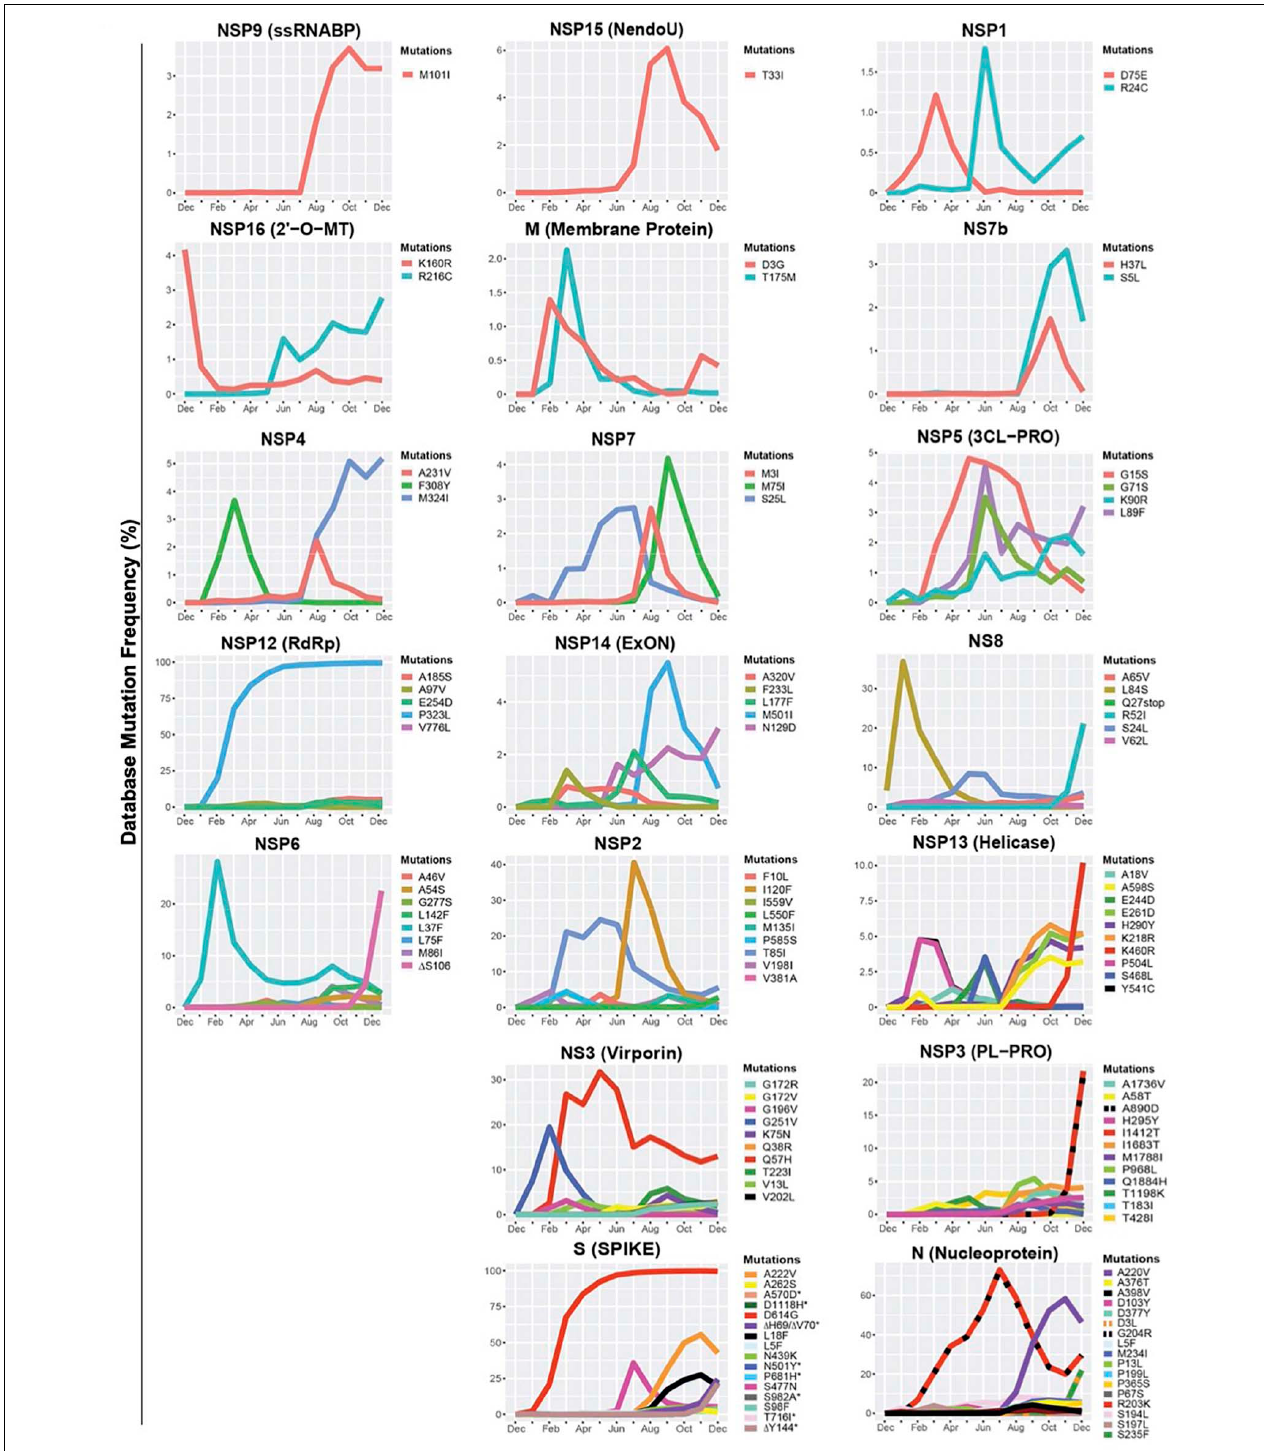
FIGURE 1 | Variations in mutations and mutation frequencies in severe acute respiratory syndrome Coronavirus 2 (SARS-CoV-2) genes. The occurrence and frequency of mutations in various SARS-CoV-2 genes are presented for the period between December 2019 and January 1, 2021. Plotted are mutations that reached at least a 1% worldwide frequency. SARS-CoV-2 genes are represented with the function of the genes in parentheses. Graphs were generated using RStudio. *Overlapping curves.